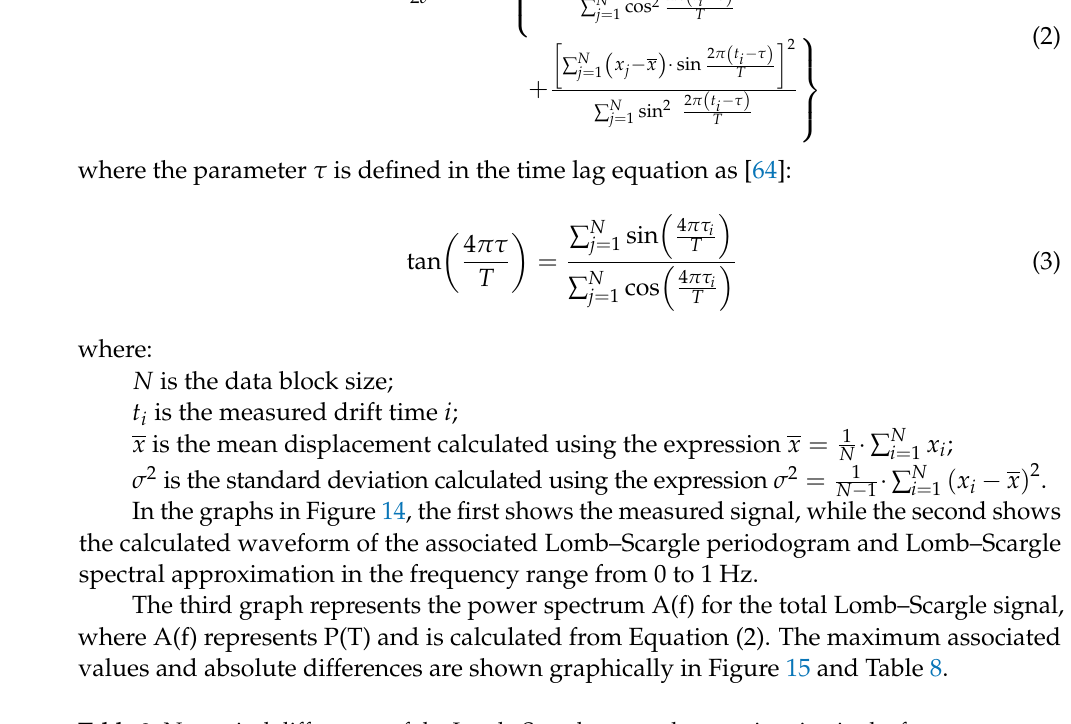
Table 8. Numerical differences of the Lomb–Scargle spectral approximation in the frequency range from 0 to 1